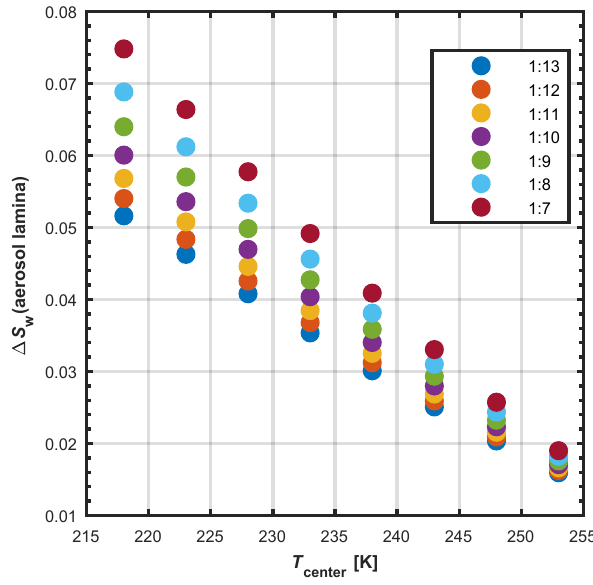
Figure D1. Example of S w profile for the mid-portion of the verti- cal distance between the cold (at z = 0cm, bottom) and warm (at z = 2cm, top) wall of the HINC chamber, illustrating the varia- tions in S w across the aerosol lamina (black solid line) for sam- ple conditions of T center = 218K, S w , center = 1 . 05 and different F AP /F sheath flow ratios (red and blue shading). The S w profiles given by the dashed and dash-dotted lines take into account uncer- tainty in temperature control arising from the thermocouples. The red, dashed line indicates the position where particles are injected into HINC.